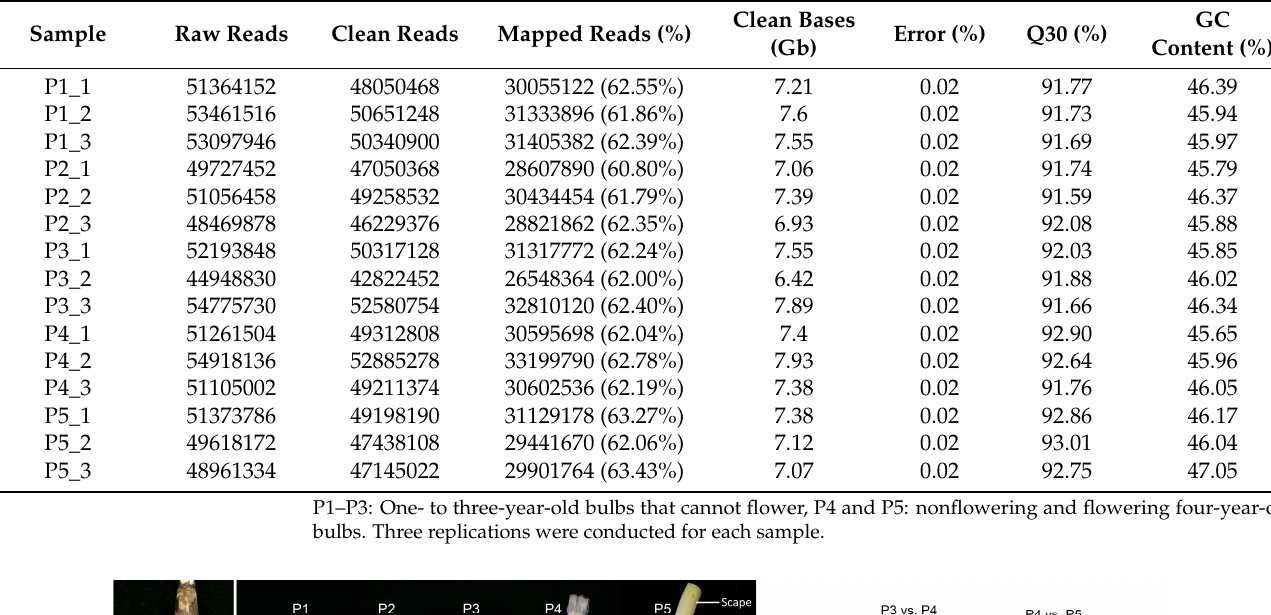
Table 1. Summary of the RNA-Seq results in the bulb meristem of L. chinensis .